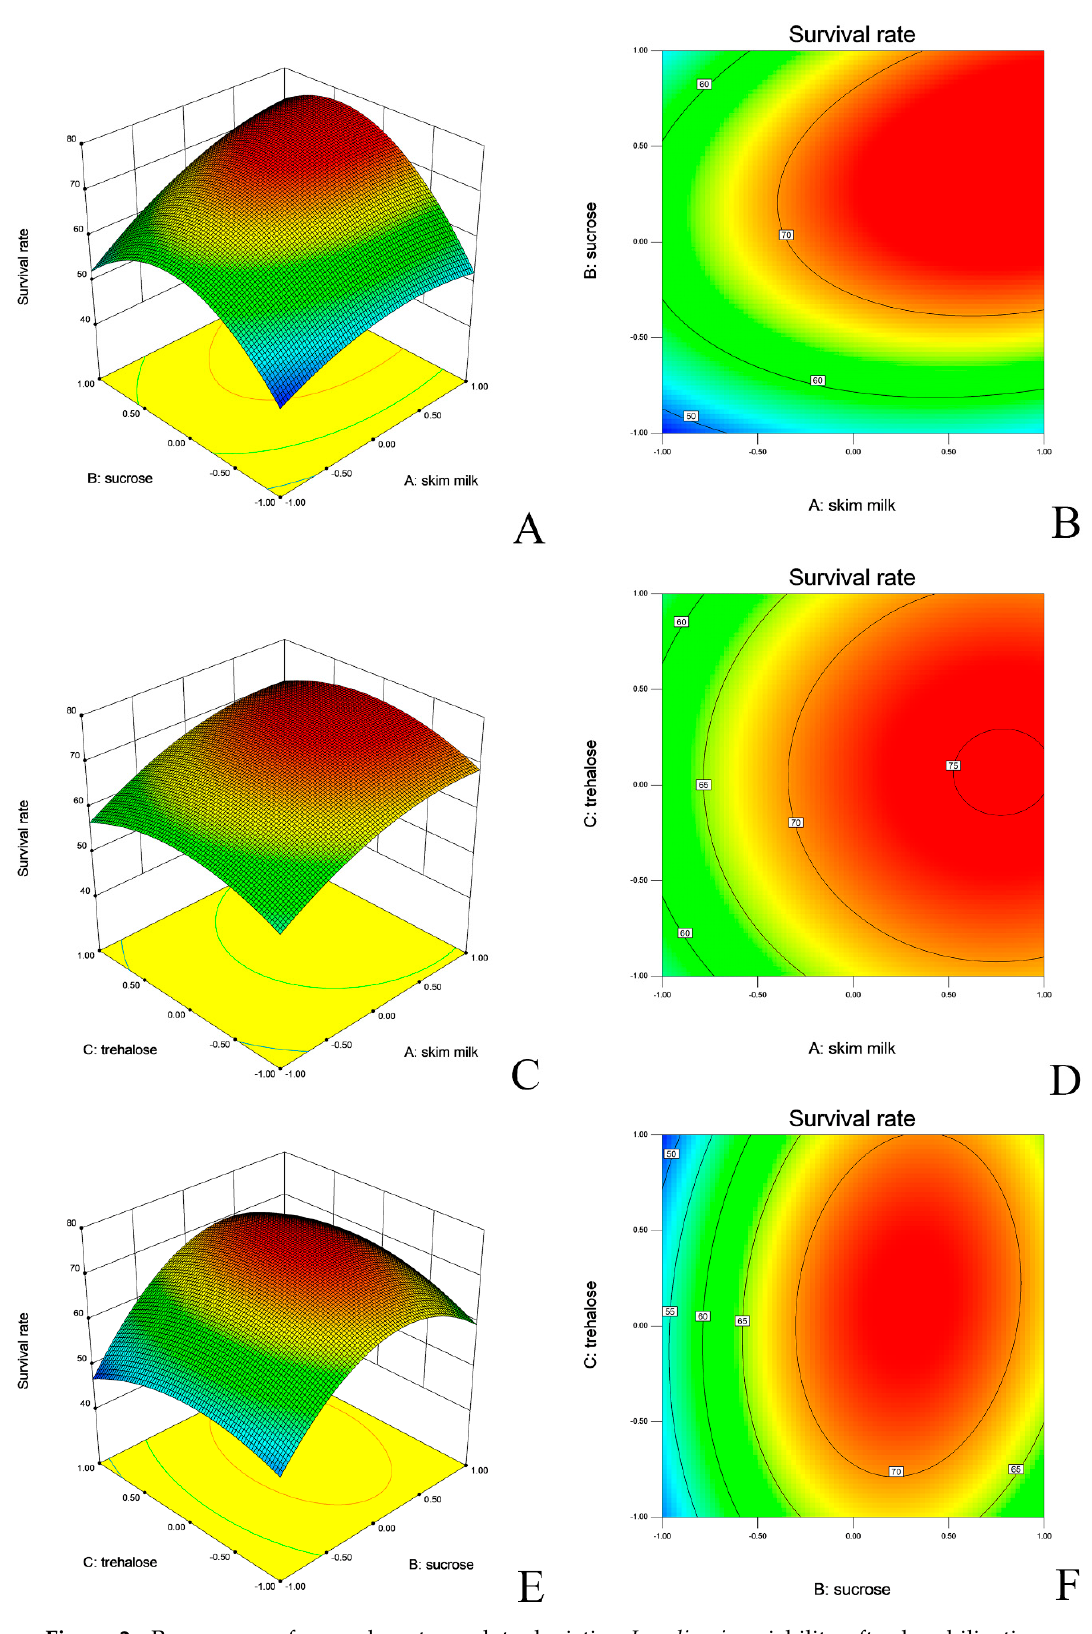
Figure 2. Response surface and contour plots depicting L. salivarius viability after lyophilization. A , B : skim milk vs sucrose. C , D : skim milk vs. trehalose. E , F : sucrose vs. trehalose.